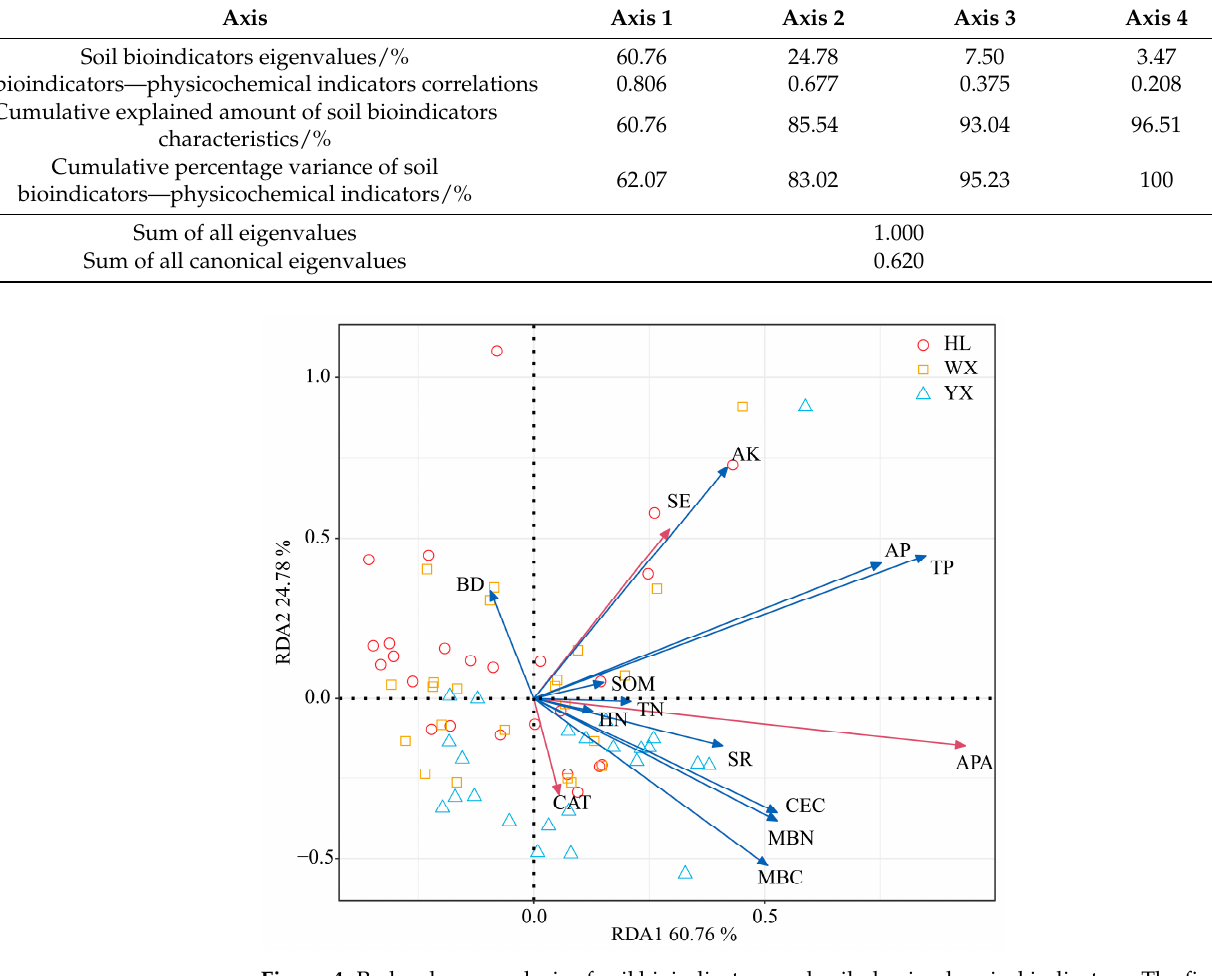
Figure 4. Redundancy analysis of soil bioindicators and soil physicochemical indicators. The figure shows only the explanatory factor variables that have a significant effect on the soil biological indicators. HL: Hailun county; WX: Wen county; YX: Yixing county.